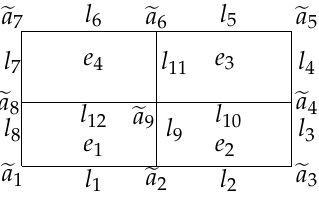
Figure 1. New element (cid:101) e